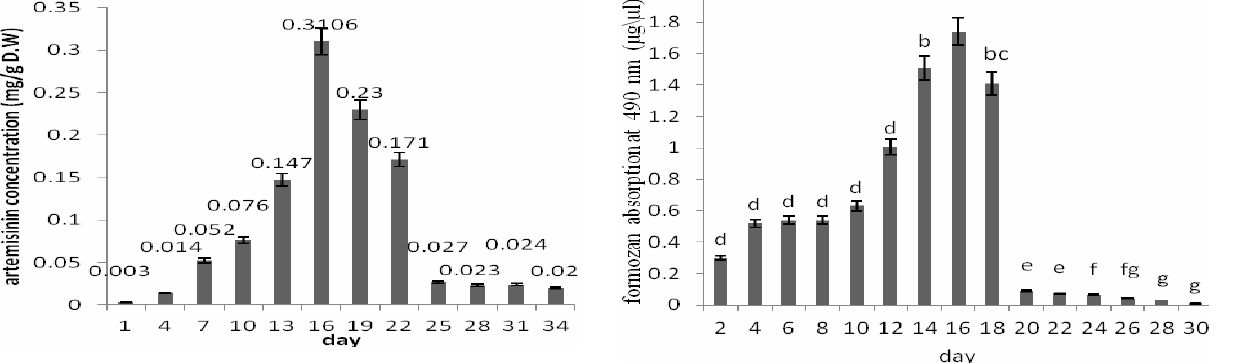
Fig. 14. The formozan absorption by spectrophotometer within 30